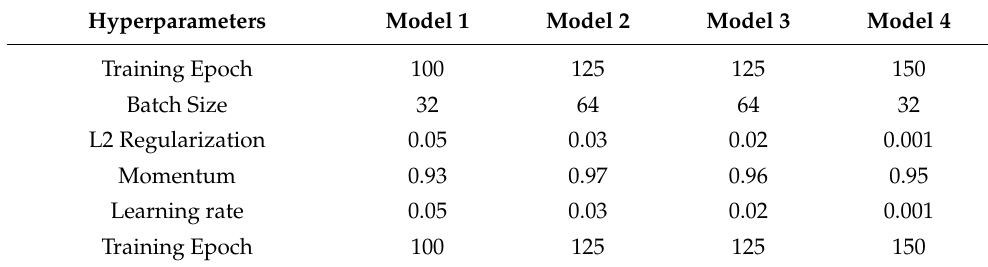
Table 4. Experimental hyperparameters of GA(SAE)-SVM.